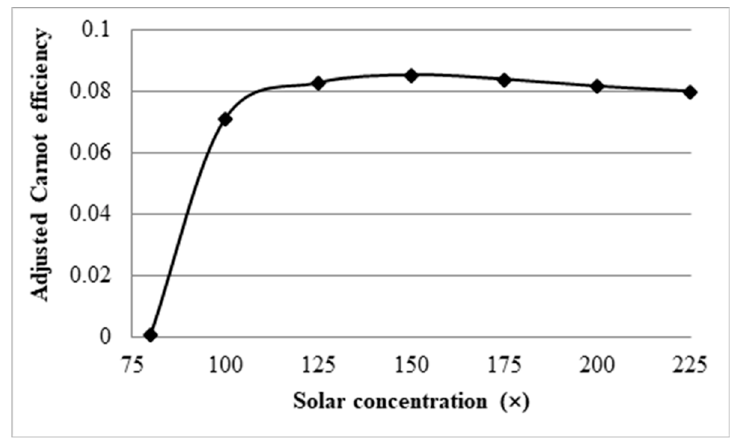
Figure 19. Effect of solar concentration on efficiency at a constant peak temperature.